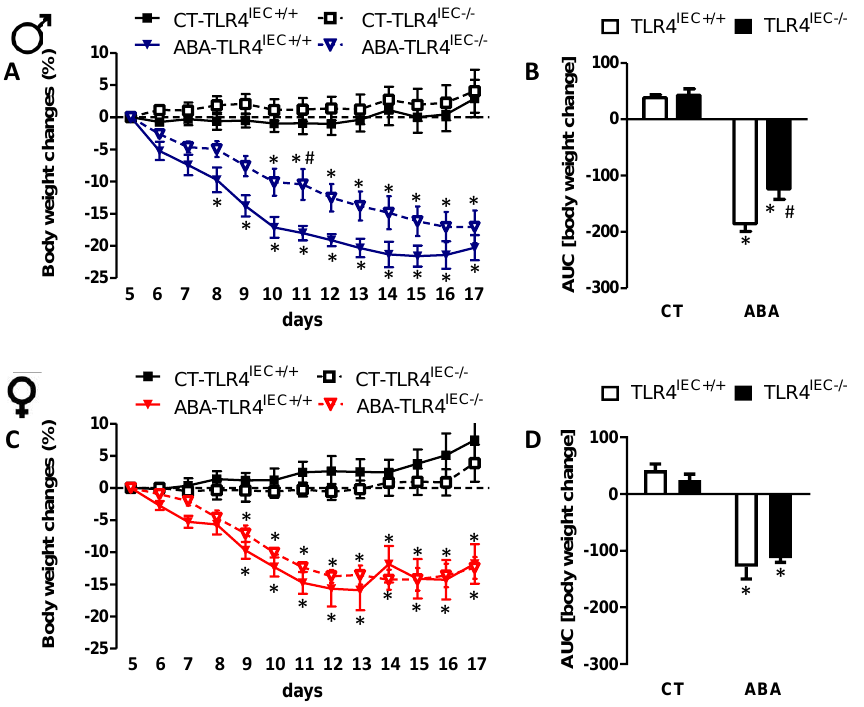
Figure 1. Body weight change in male and female mice. Body weight change from d5 to d17 ( A ), in control (CT-TLR4 IEC+/+ , closed squares), CT-TLR4 IEC − / − (open squares), ABA-TLR4 IEC+/+ (closed triangles) and ABA-TLR4 IEC − / − (open triangles) male mice. Area under cover ( B ) between at the left CT TLR4 IEC+/+ (open bars) and TLR4 IEC − / − (closed bars) and at the right ABA TLR4 IEC+/+ (open bars), TLR4 IEC − / − (closed bars) male mice. Body weight change from d5 to d17 ( C ), in control (CT-TLR4 IEC+/+ , closed squares), CT-TLR4 IEC − / − (open squares), ABA-TLR4 IEC+/+ (closed triangles) and ABA-TLR4 IEC − / − (open triangles) female mice. Area under cover ( D ) between at the left CT TLR4 IEC+/+ (open bars) and TLR4 IEC − / − (closed bars) and at the right ABA TLR4 IEC+/+ (open bars), TLR4 IEC − / − (closed bars) female mice. The results of the Bonferroni post hoc tests are shown: *, p < 0.05 vs. CT; #, p < 0.05 vs. TLR4 IEC+/+ .